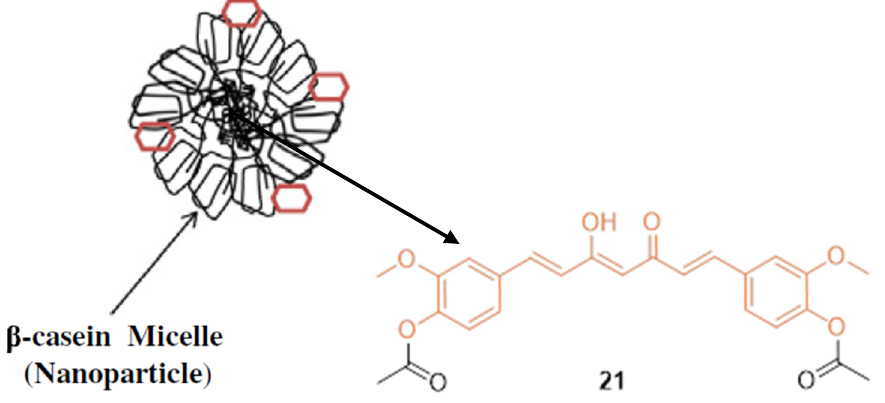
Figure 3. Interaction of diacetylcurcumin (DAC) with bovine β -casein.